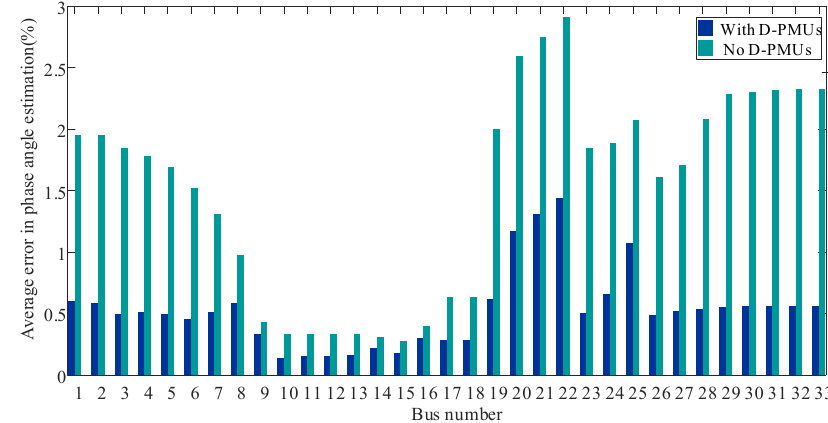
Figure 6. Comparison of average errors in voltage amplitude.